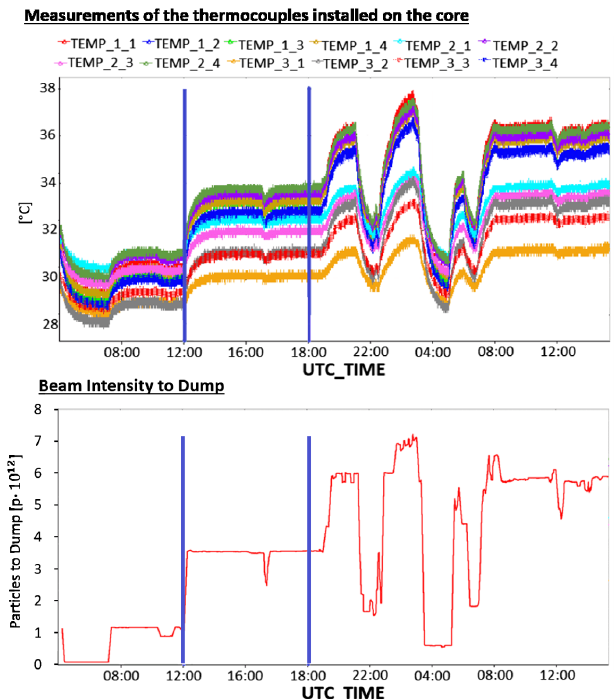
FIG. 21. Above: Measurements of the thermocouples installed on the dump core during the time period between 04:00 on the 11th of March, 2018 and 15:00 of the following day. Below: Ten- minute moving average of the intensity extracted to the dump in the corresponding time period.